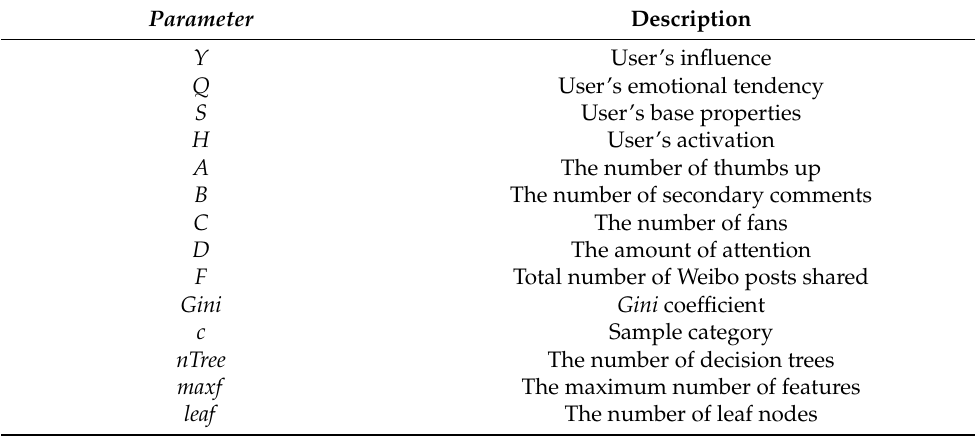
Table 1. Relevant parameters.